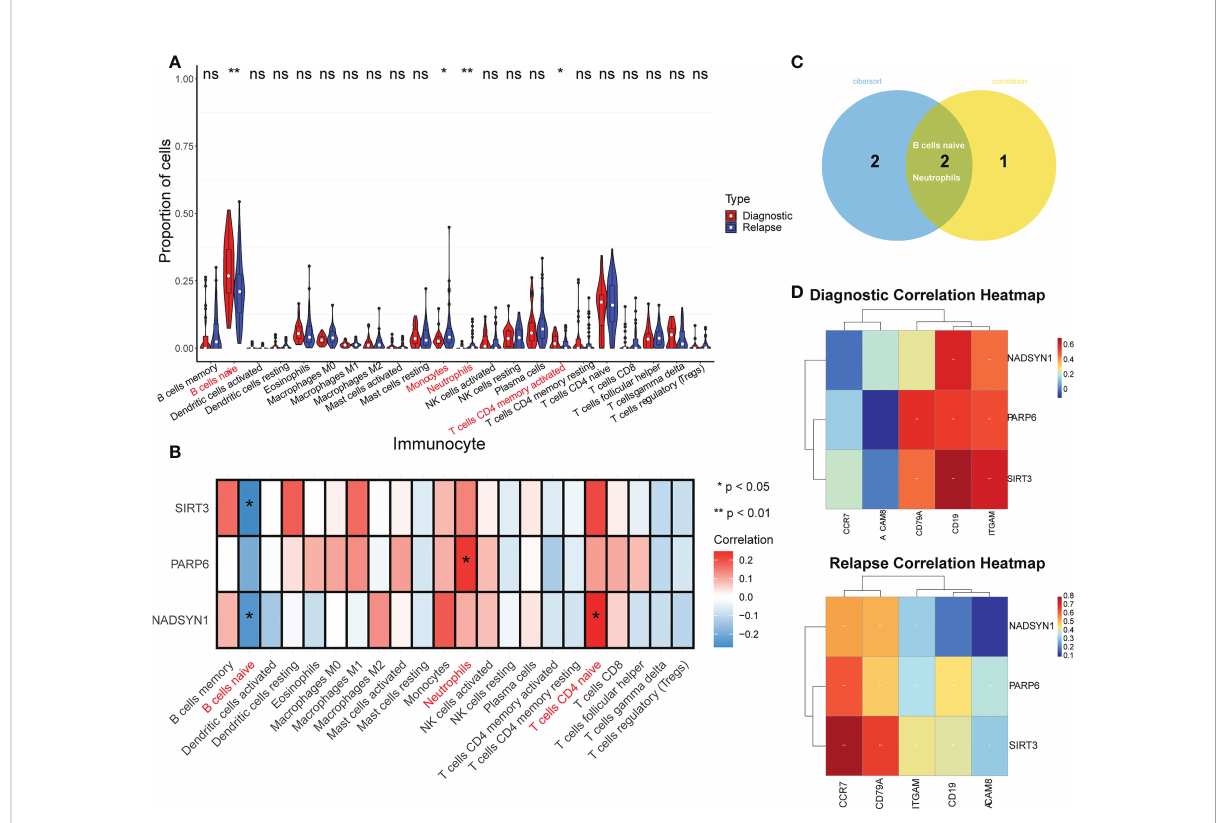
FIGURE 3 TME analysis in GSE3912. (A) Immune in fi ltration differences between initially diagnosed and relapse groups ( p < 0.05). * represents p < 0.05, ** represents p < 0.01, ns represents no signi fi cance. (B) The correlation analysis of immune cells and NADSYN1, PARP6, SIRT3. (C) A Venn- diagram of the differentially expressed immune cells (DEIs) and signi fi cantly biomarkers-related immune cells to obtain key DEIs. (D) The correlation heatmaps of biomarkers and corresponding gene markers of key DEIs in initially diagnosed and relapse